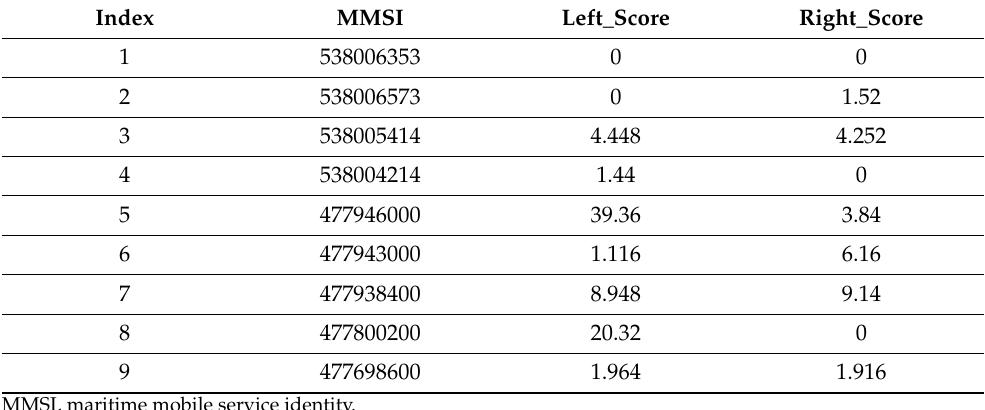
Table 1. Score of vessel trajectory after signature transform.